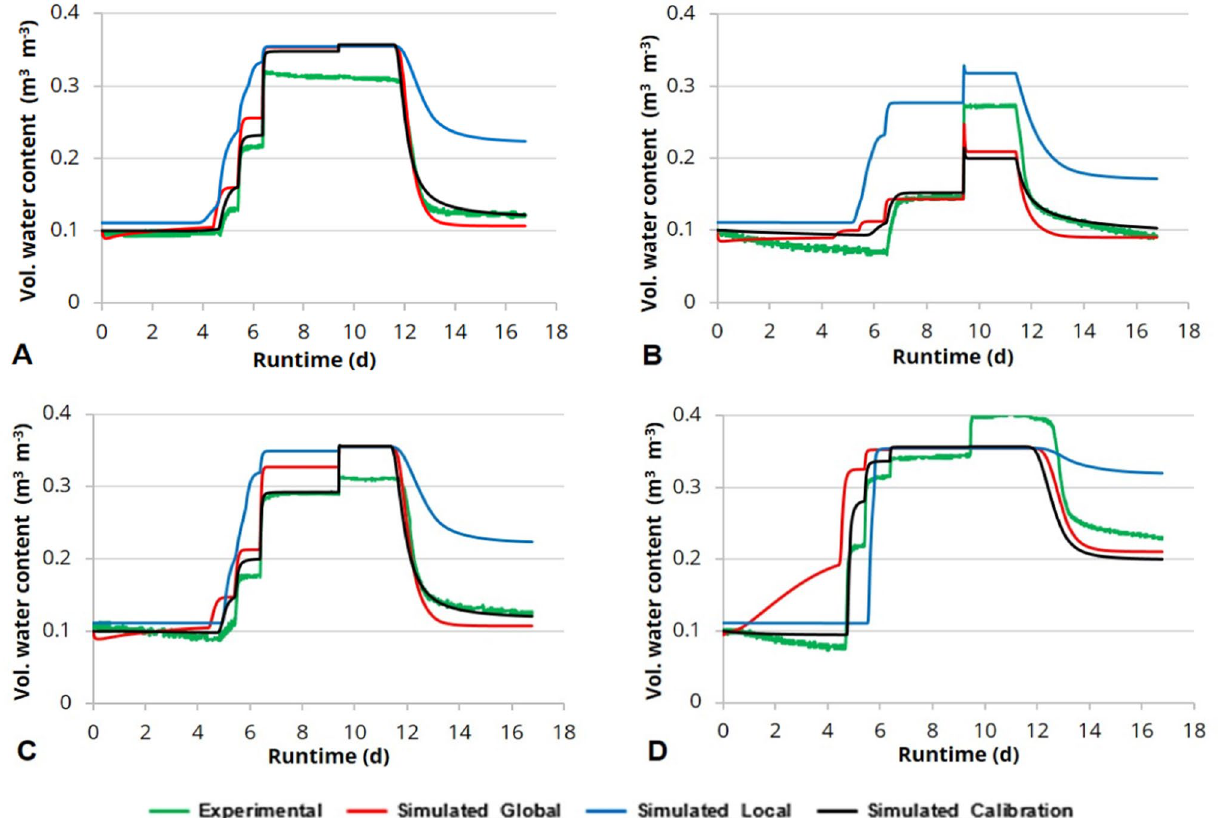
Fig. 3 Observed (green) and simulated water content for soil 1 at the observation points H1 ( A ), H3 ( B ), H4 ( C ) and H7 ( D ) by using basic hydraulic soil parameters originating from local (blue) and global (red) measurement as well as after calibration process